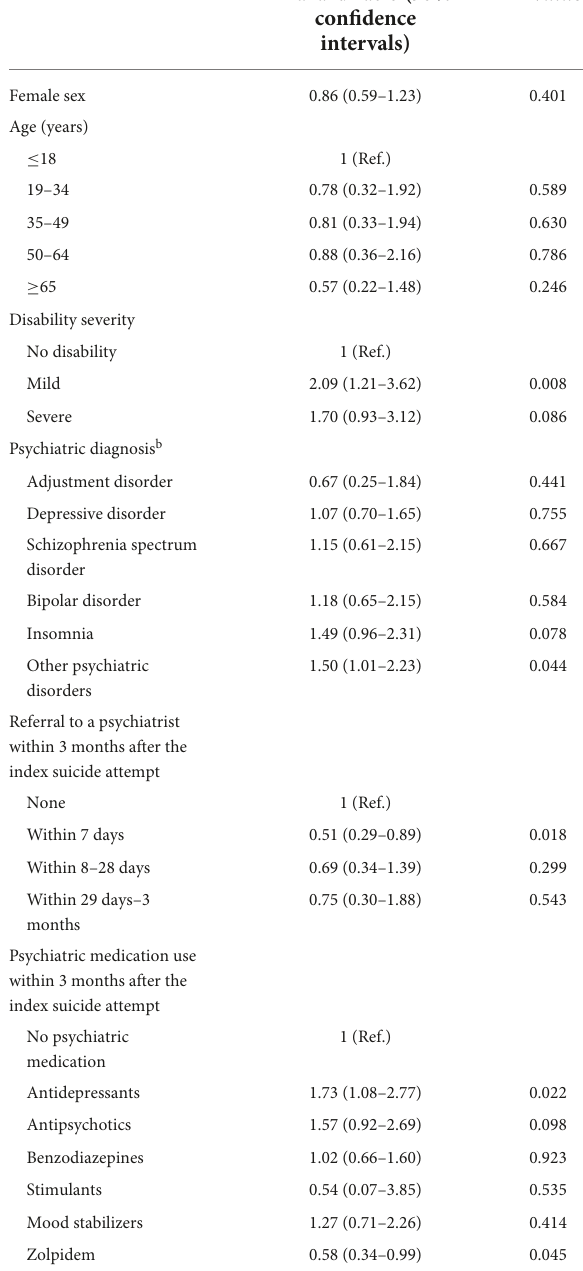
TABLE 4 Adjusted hazard ratios of potential risk factors for suicide reattempt among subjects who attempted suicide had not reattempted suicide or died within the 3-month period after the index suicide attempt ( n = 4,842) a